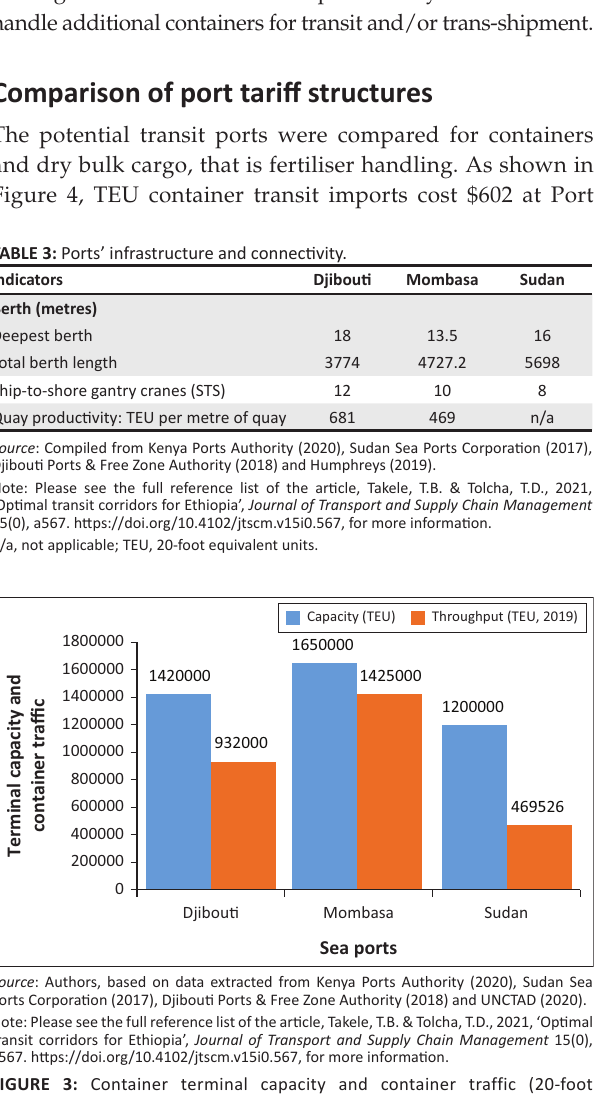
FIGURE 3: Container terminal capacity and container traffic (20-foot equivalent units).